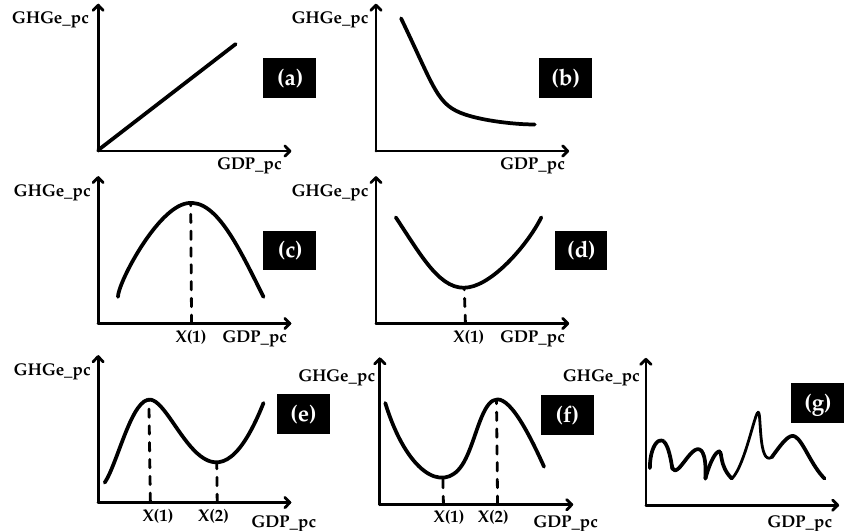
Figure 1. Possible links between environmental quality and GDP per capita. ( a ) If β 1 > 0, β 2 = β 3 = 0, there is an increasing monotonic relationship, such that high levels of income are associated with high levels of pollution; ( b ) If β 1 < 0, β 2 = β 3 = 0, there is a decreasing monotonic relationship, such that high levels of income are associated with decreasing levels of pollution; ( c ) If β 1 > 0, β 2 < 0, and β 3 = 0, a quadratic relationship in an inverted U ‐ shaped pattern indicates that high levels of income are associated with decreasing levels of pollution, beyond a certain level of income; ( d ) If β 1 < 0, β 2 > 0, and β 3 = 0, there is a quadratic relationship in a U ‐ shaped pattern, in direct contrast with the Environmental Kuznets Curve (EKC); ( e ) If β 1 > 0, β 2 < 0, and β 3 > 0, a cubic polynomial reveals an N shape, such that the inverted U ‐ shaped pattern occurs up to a certain point, after which pollution increases again; ( f ) If β 1 < 0, β 2 > 0, and β 3 < 0, we have a cubic polynomial in an inverted N shape; ( g ) If β 1 = β 2 = β 3 = 0, flat behavior indicates that emissions are not influenced by the level of income [8].